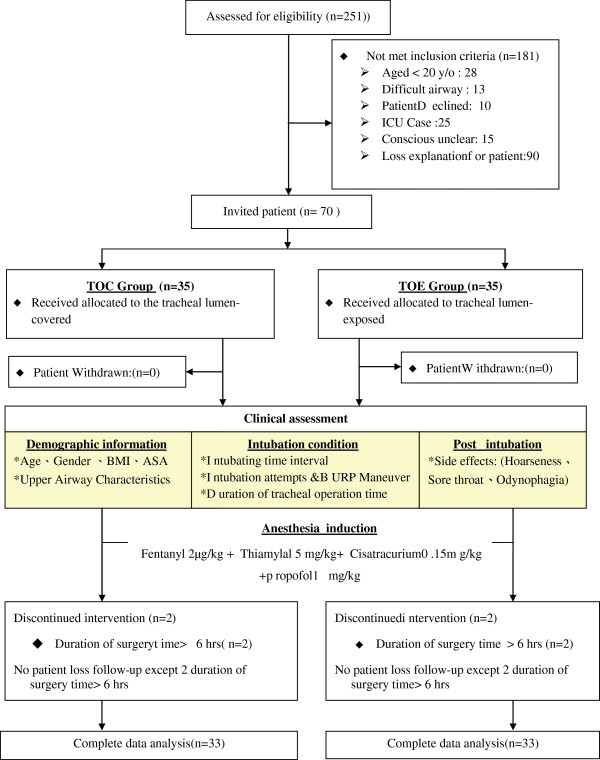
Study flow diagram.